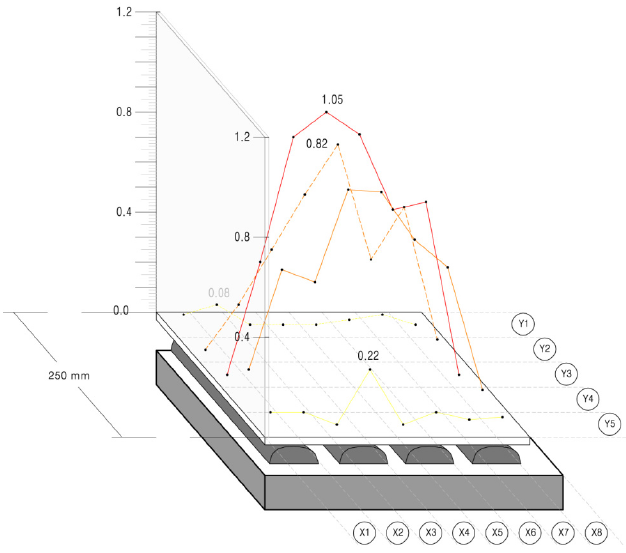
Figure 15. AR 80 ± 2% specimen adhesion strength per piece coordinate (average).